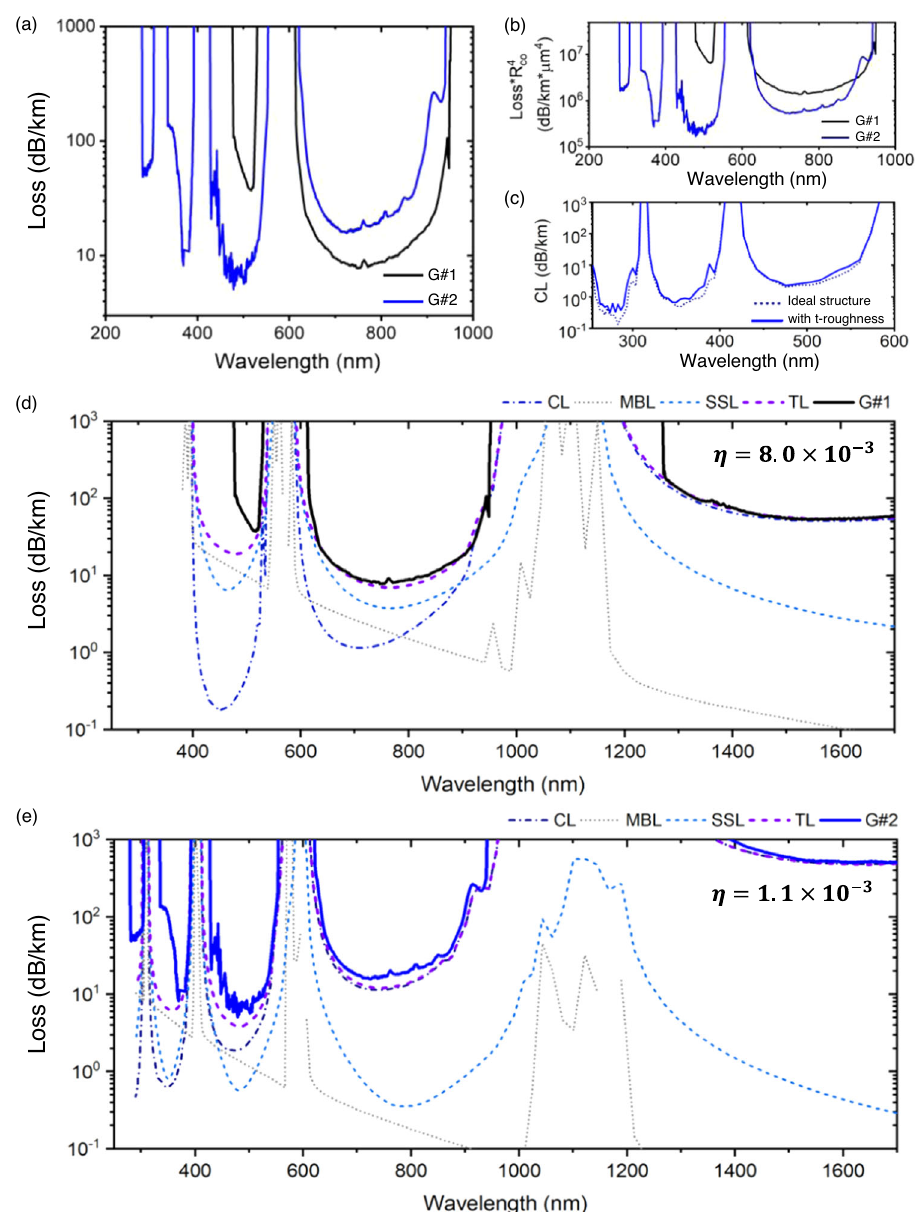
Fig. 4 | Loss trends comparison and total loss analysis. a Representative mea- suredlossspectrafor fi bersinG#1andG#2showingthedifferentlosstrendsinthe short-wavelengthrange. b Normalizationofthemeasured fi berlosswithrespectto the fi bercoreradius(R co ). c StudyoftheimpactoftransverseroughnessontheCL.